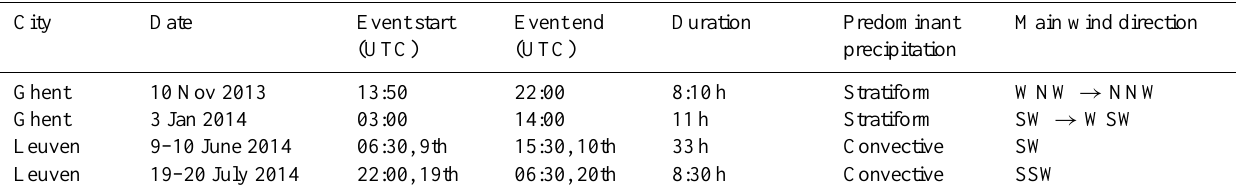
Table 1. List of precipitation events that caused sewer system floods in Ghent and Leuven. City Predominant